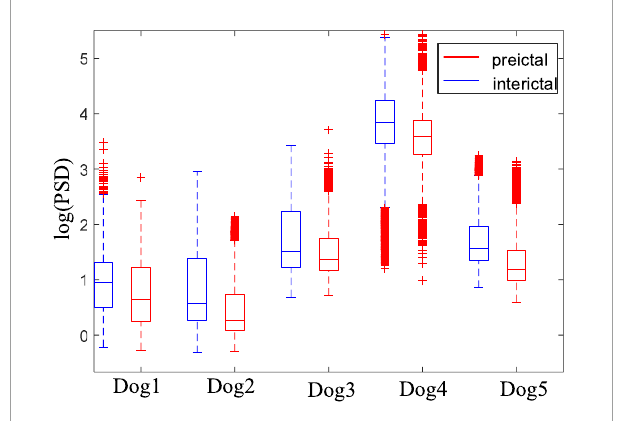
FIGURE5 Comparison of power spectral density (PSD) between preictal and interictal states for five canines in the Kaggle